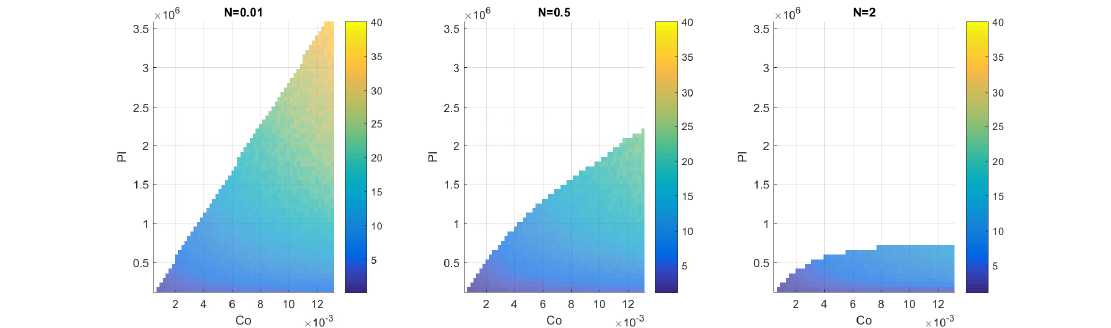
Figure 9. Frequency of oscillations as a function of Co and Pl for different values of N for TOA = 4.24.